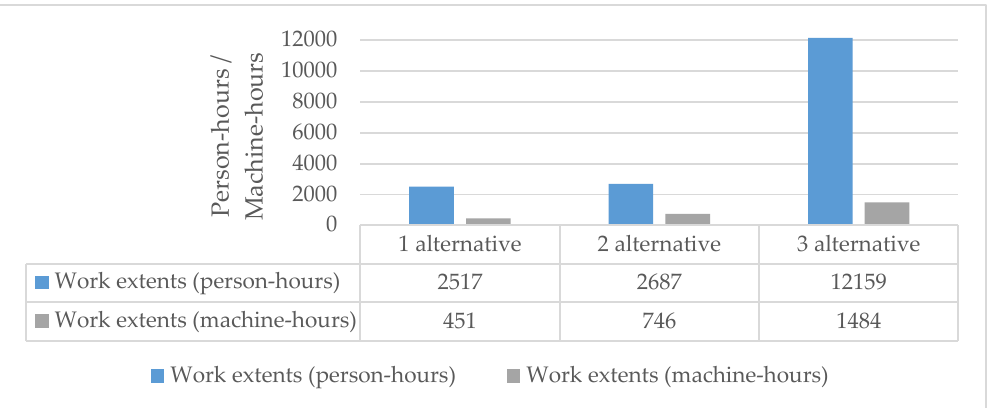
Figure 11. Comparison of technological parameters.